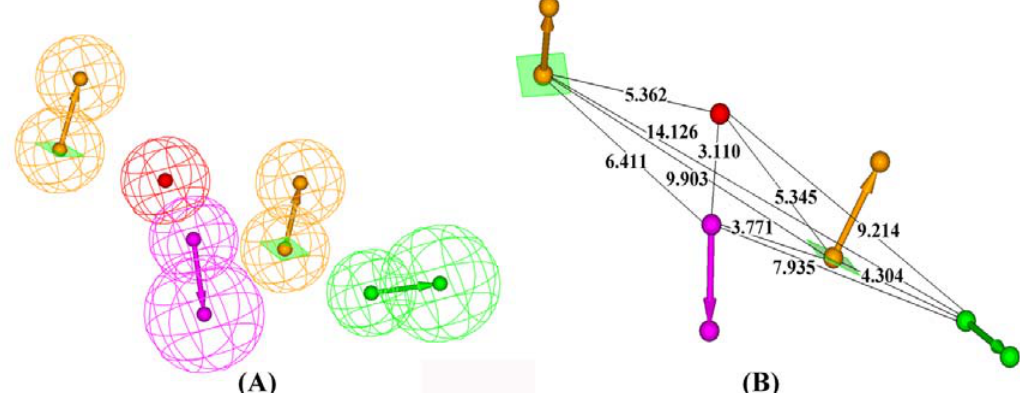
-adrenoreceptor agonists generated by HipHop. 2